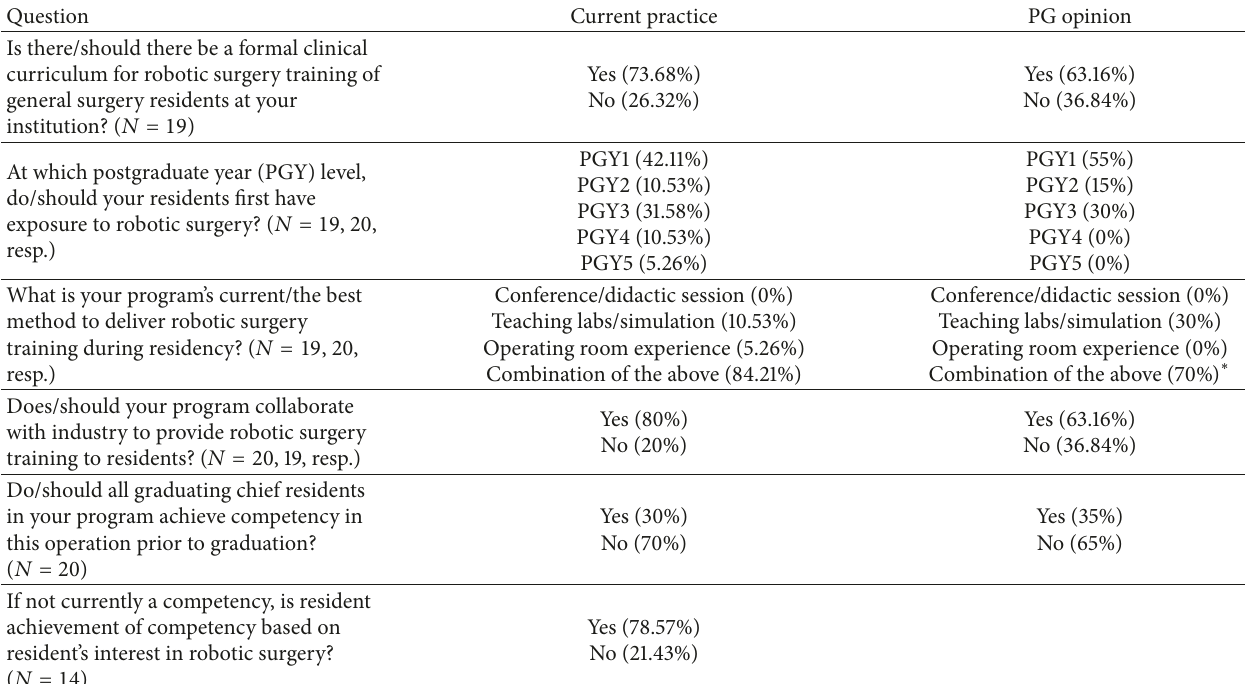
Table 3: Comparison of current robotic surgery training to program director